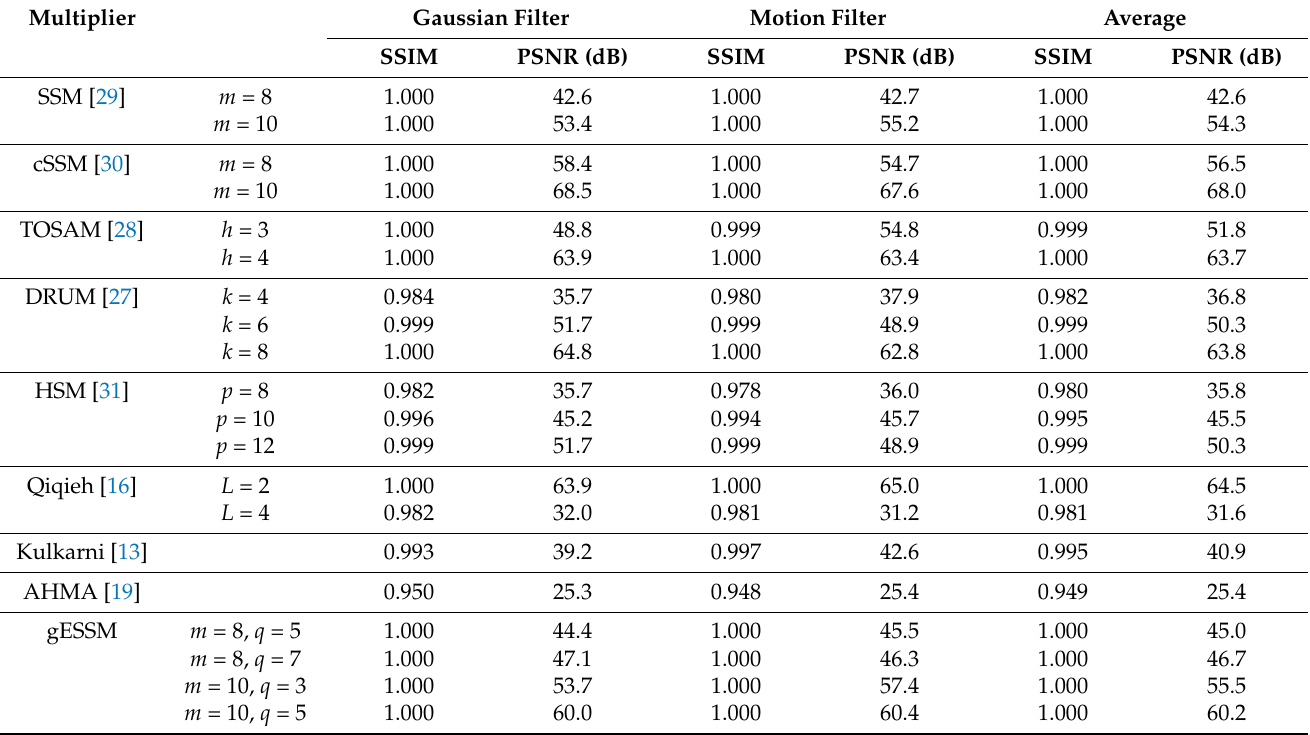
Table 6. Accuracy performances of the investigated multipliers in image processing applications. Multiplier Gaussian Filter Motion